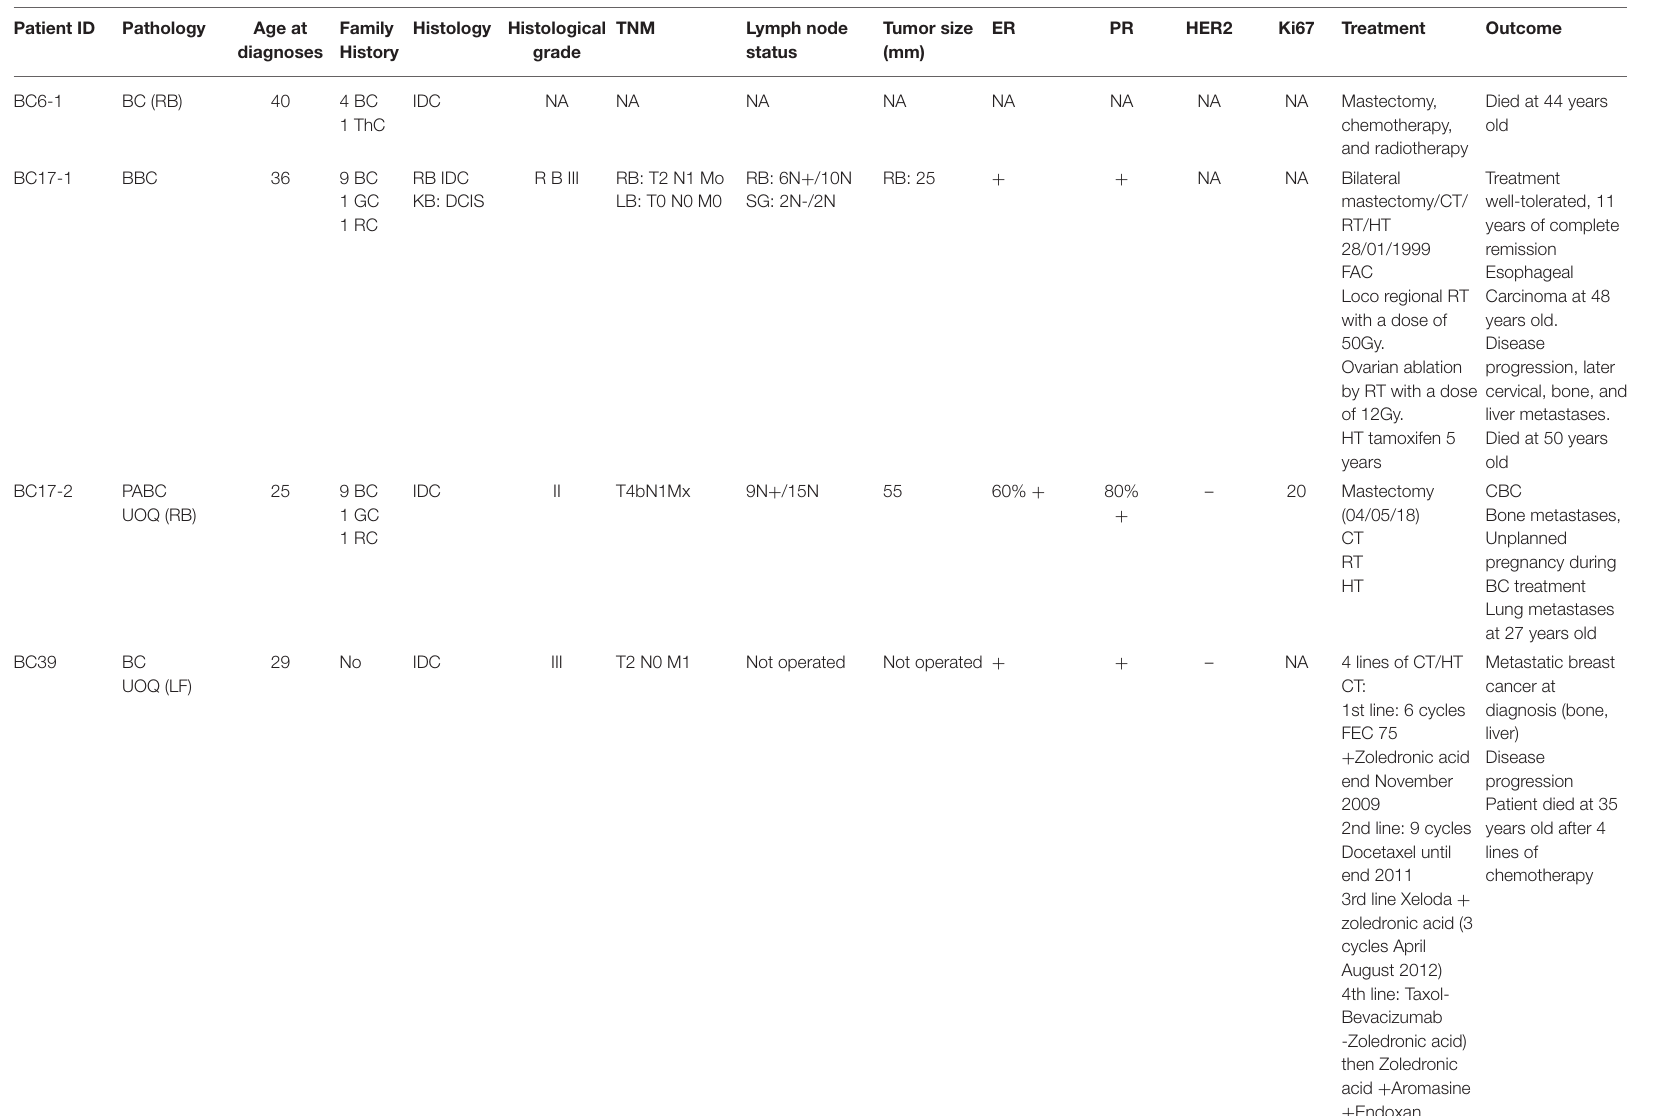
TABLE 2 | Epidemiological and clinical data of Cis double heterozygous